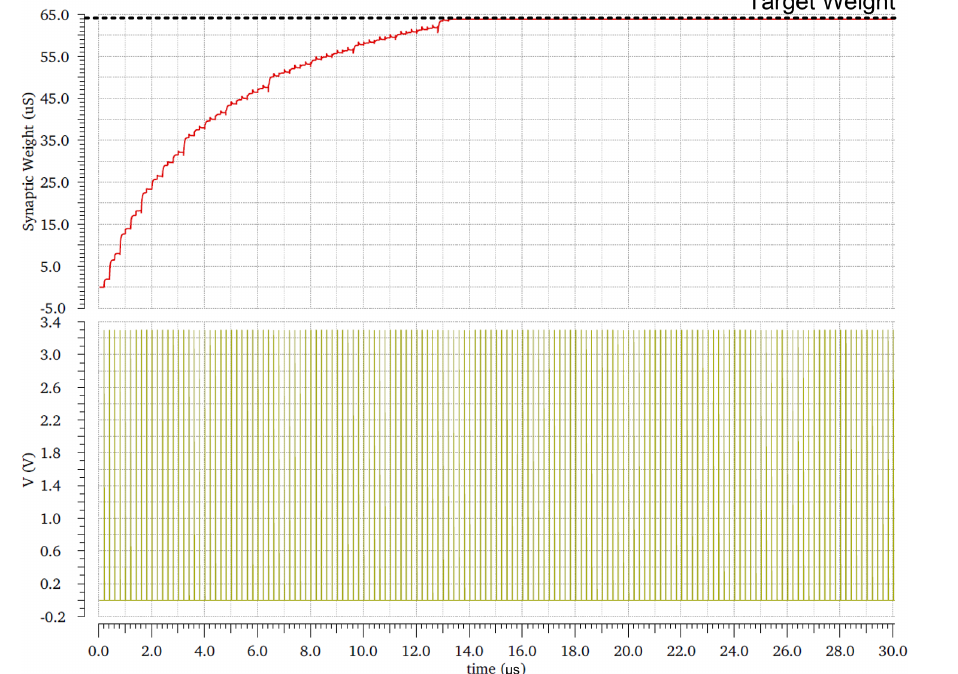
Figure 32. Target weight at V LEAK equal to 500mV, vg1 and vg2 equal to 1V, and V RFR equal to 800mV. Circuit conditions are V dd of 3 . 3V, and temperature equals 27 ◦ C and on the nominal